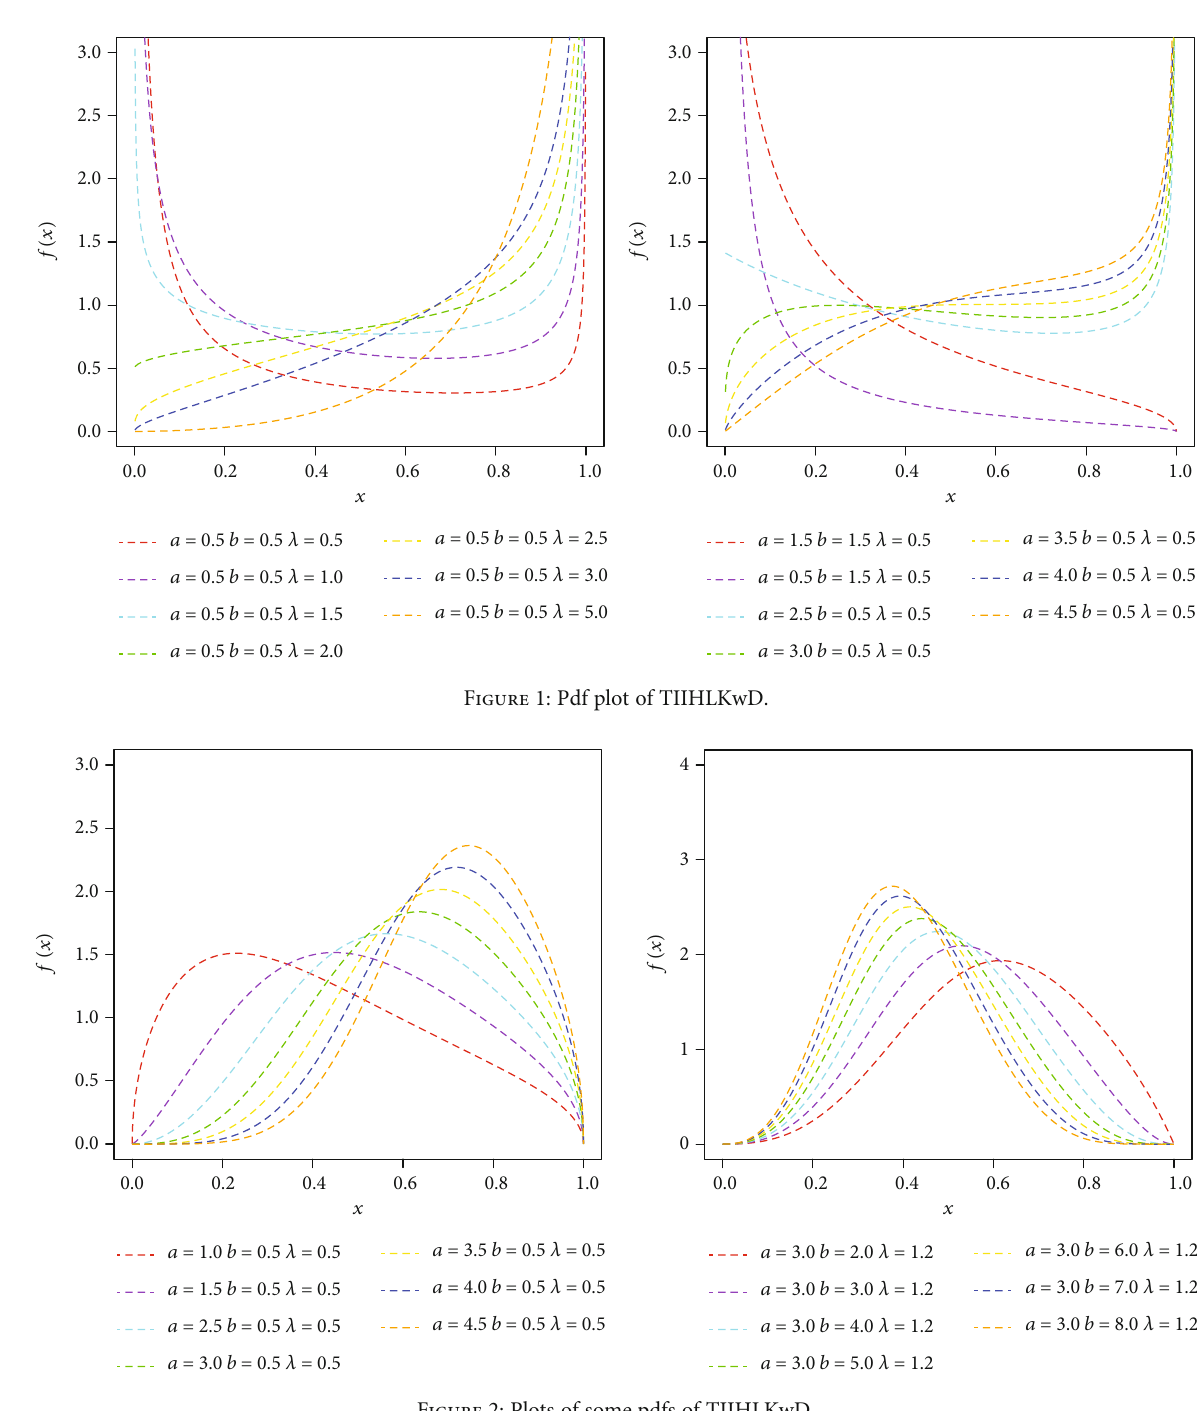
Figure 2: Plots of some pdfs of